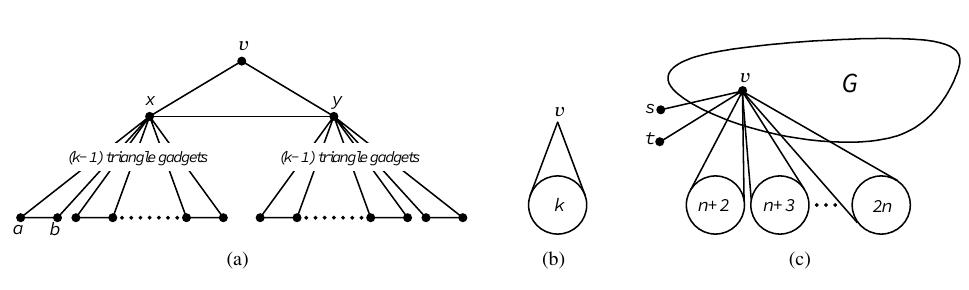
Fig. 1: A k -disallowing gadget (a) and its symbolic representation (b); a construction of h ( G )